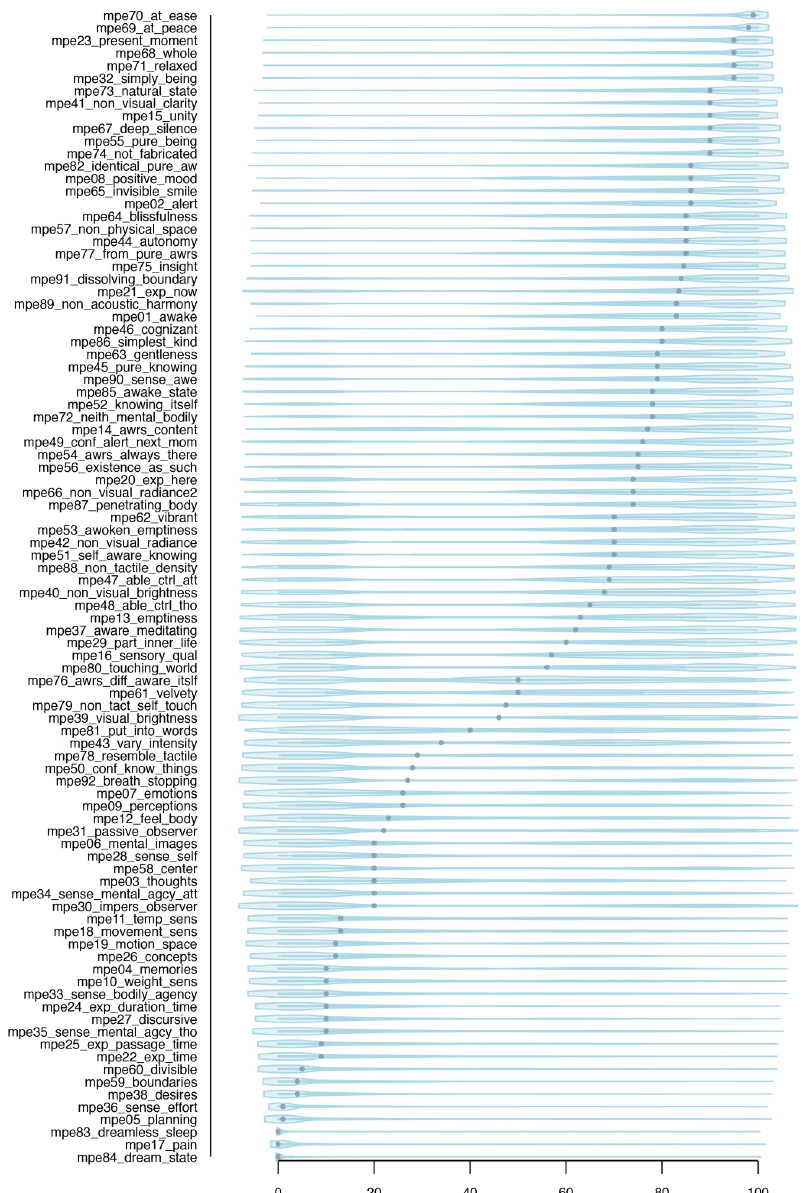
Fig 3. Distribution of questionnaire items. Statistical distribution of questionnaire items in analysis sample (N = 1403). Dots indicate